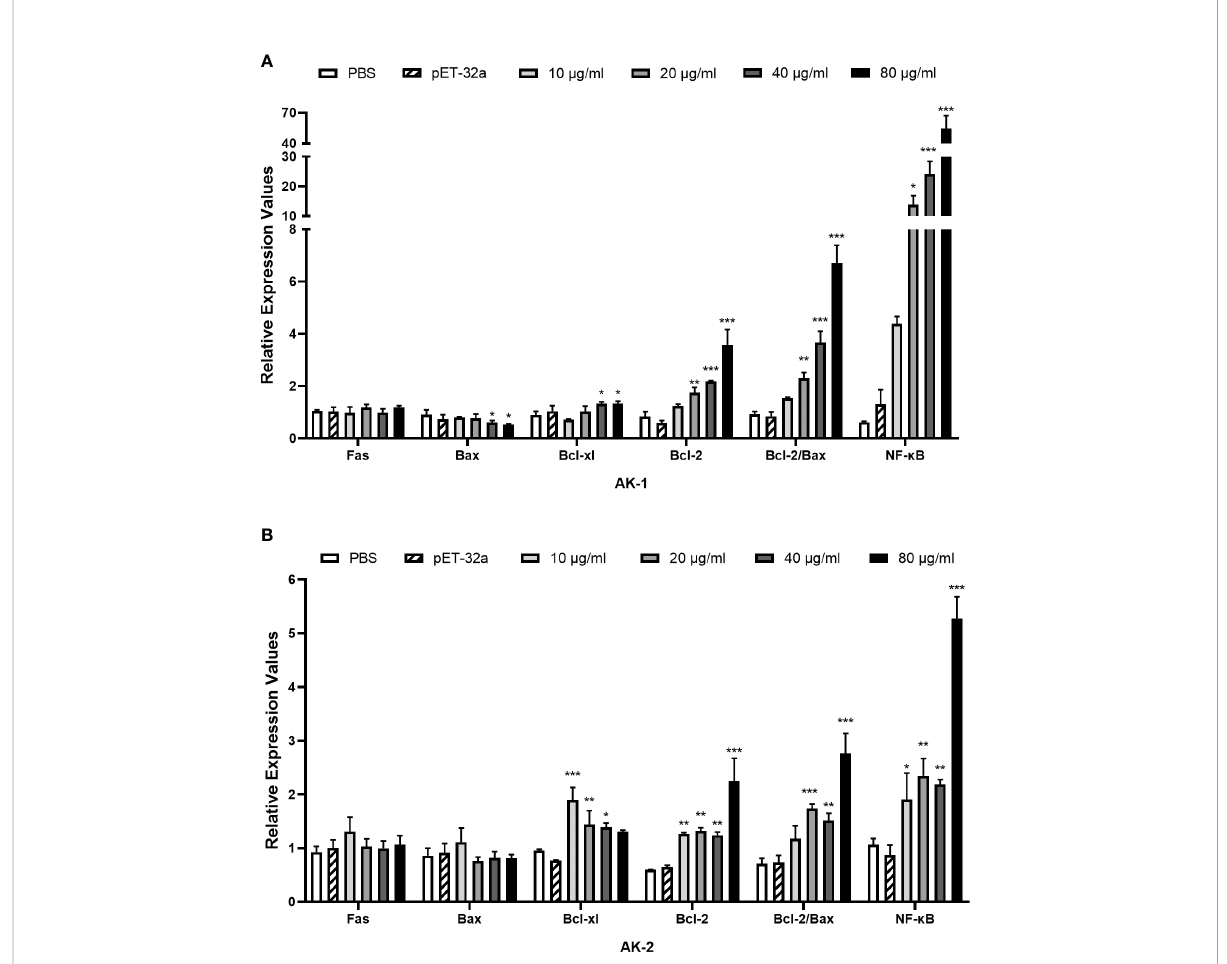
FIGURE 8 qRT-PCR results of the effects of the rSsAKs on pro-apoptotic genes, anti-apoptotic genes, and NF- k B (p65). (A, B) The effect of rSsAK-1 (A) and rSsAK-2 (B) on the proapoptotic genes (Fas, Bax), anti-apoptotic genes (Bcl-2, Bcl-xl), and NF- k B (p65) transcription levels. Data are the mean ± SD of three replicates per group as compared to the PBS group. * P < 0.05, ** P < 0.01, *** P <